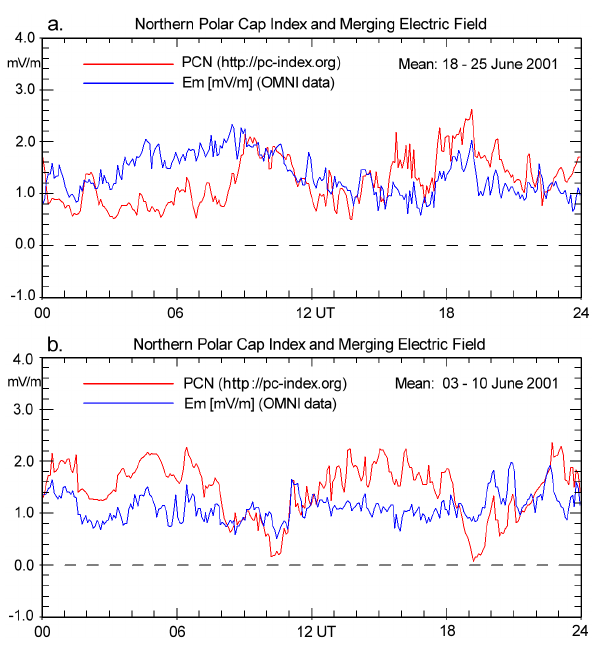
Figure 5. Display of 8-day averages of PCN-IAGA indices and E M - OMNI values. (a) 18–25 June 2001 for positive (cid:49)H SS . (b) 3–10 June 2001 for negative (cid:49)H SS